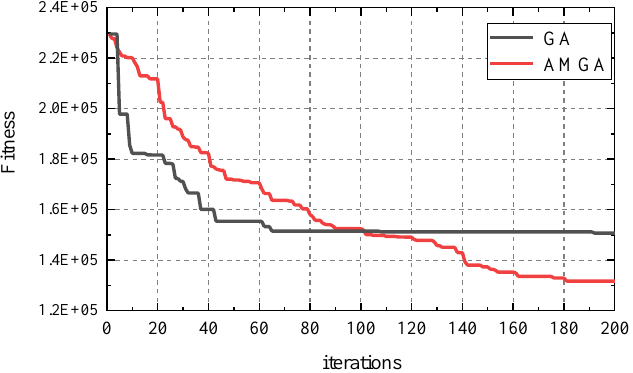
Figure 9. Flow chart of the archive-based micro genetic algorithm (AMGA) progress.